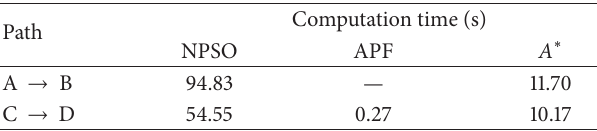
Table 6: Computation time of different algorithms for path plan-